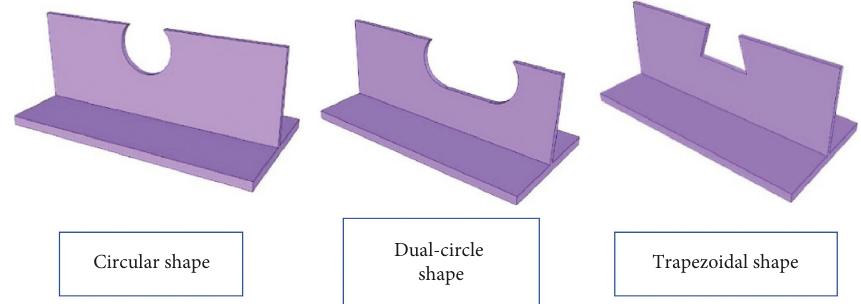
Figure 20: Different shapes of web clothoidal opening shear connectors for slim/shallow floor steel